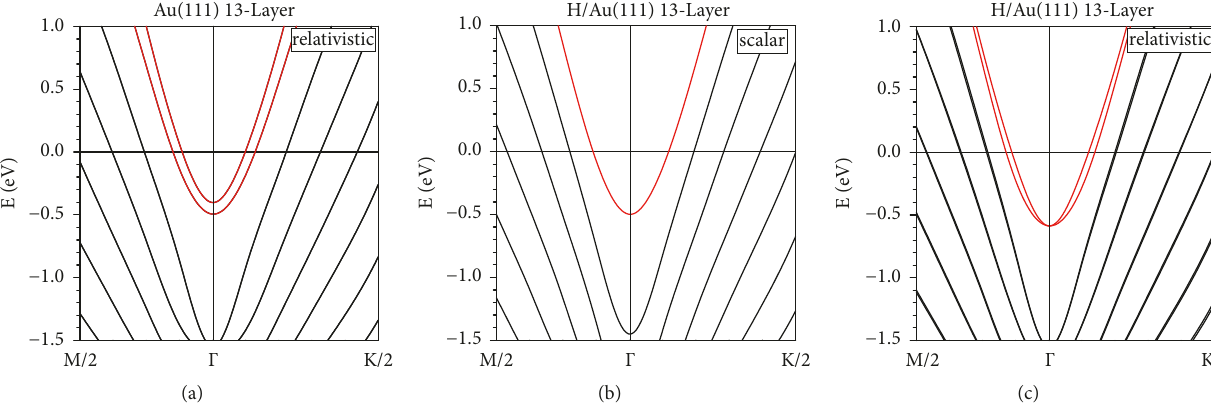
Figure 3: The band structure calculated for the 23-layer Au(111) slab in semirelativistic (a) and full relativistic (b) approximations. relativisticAu(111) 13-Layer